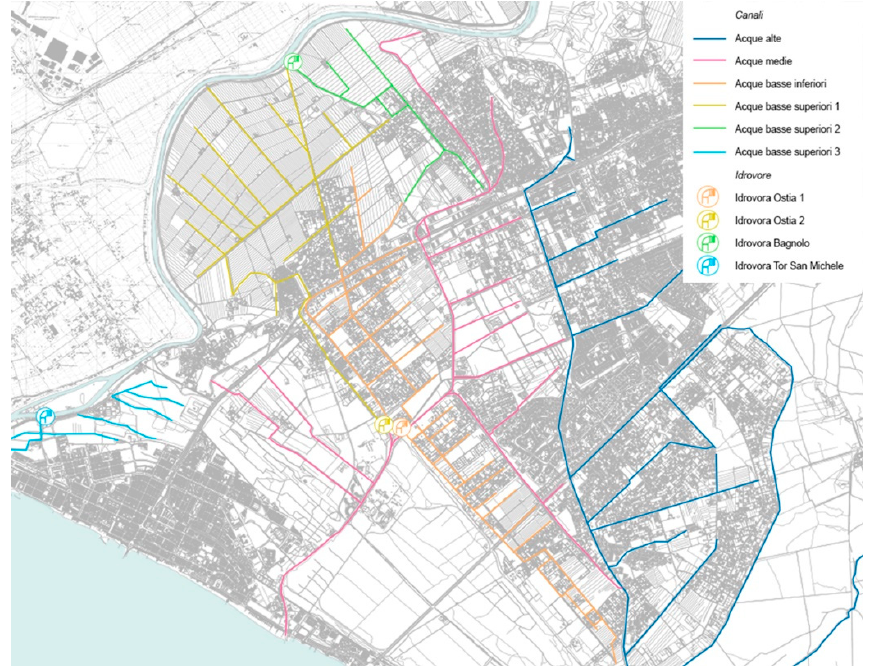
Figure 4. Analysis of the flow senses of the drainage channels of the Agro Romano. (Source: https://qgiscloud.com/CBLN/CBLN1. Accessed on 24 June 2022. Elaborations by the author).